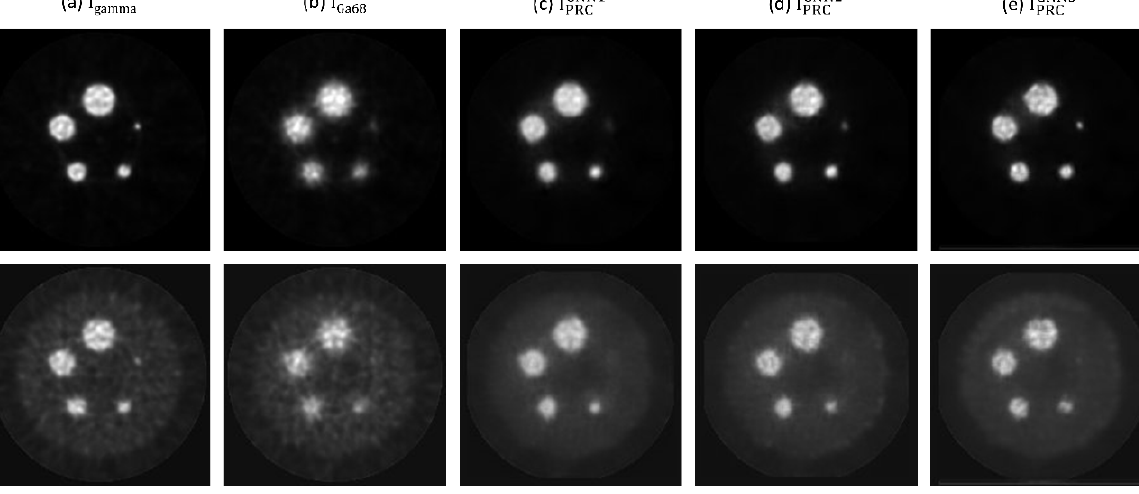
Figure 4. ( a ) I gamma , ( b ) I Ga68 , ( c ) I CNN1 , ( d ) I CNN2 , ( e ) I CNN3 of PHAN 5rod with TBR = 0 ( top row ) and TBR = 10 PRC PRC PRC Figure 4. ( a ) I , ( b ) I , ( c ) I (cid:2900)(cid:2902)(cid:2887) (cid:2887)(cid:2898)(cid:2898)(cid:2869) , ( d ) I (cid:2900)(cid:2902)(cid:2887) (cid:2887)(cid:2898)(cid:2898)(cid:2870) , ( e ) I (cid:2900)(cid:2902)(cid:2887) (cid:2887)(cid:2898)(cid:2898)(cid:2871) of PHAN with TBR = 0 (top row) and TBR = 10 (bottom row). ( bottom row gamma Ga68 5rod Figure 4. ( a ) I , ( b ) I , ( c ) I (cid:2900)(cid:2902)(cid:2887)(cid:2887)(cid:2898)(cid:2898)(cid:2869) , ( d ) I (cid:2900)(cid:2902)(cid:2887)(cid:2887)(cid:2898)(cid:2898)(cid:2870) , ( e ) I (cid:2900)(cid:2902)(cid:2887)(cid:2887)(cid:2898)(cid:2898)(cid:2871) of PHAN with TBR = 0 (top row) and TBR = 10 (bottom row). gamma Ga68 5rod